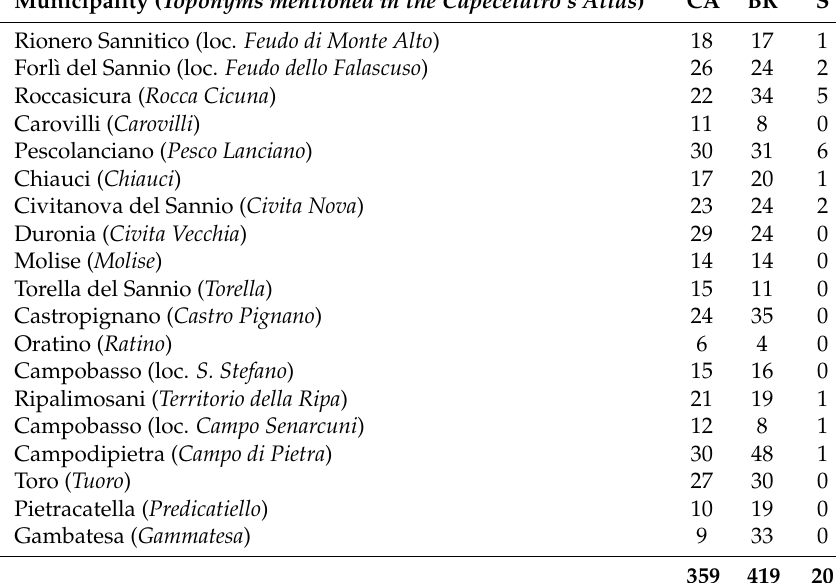
Table 3. Number of milestones present in the 18 municipalities, arranged from N to S, drawn in Capecelatro’s Atlas (CA) and in Bonamici’s reinstatement (BR), and those recorded during the field surveys